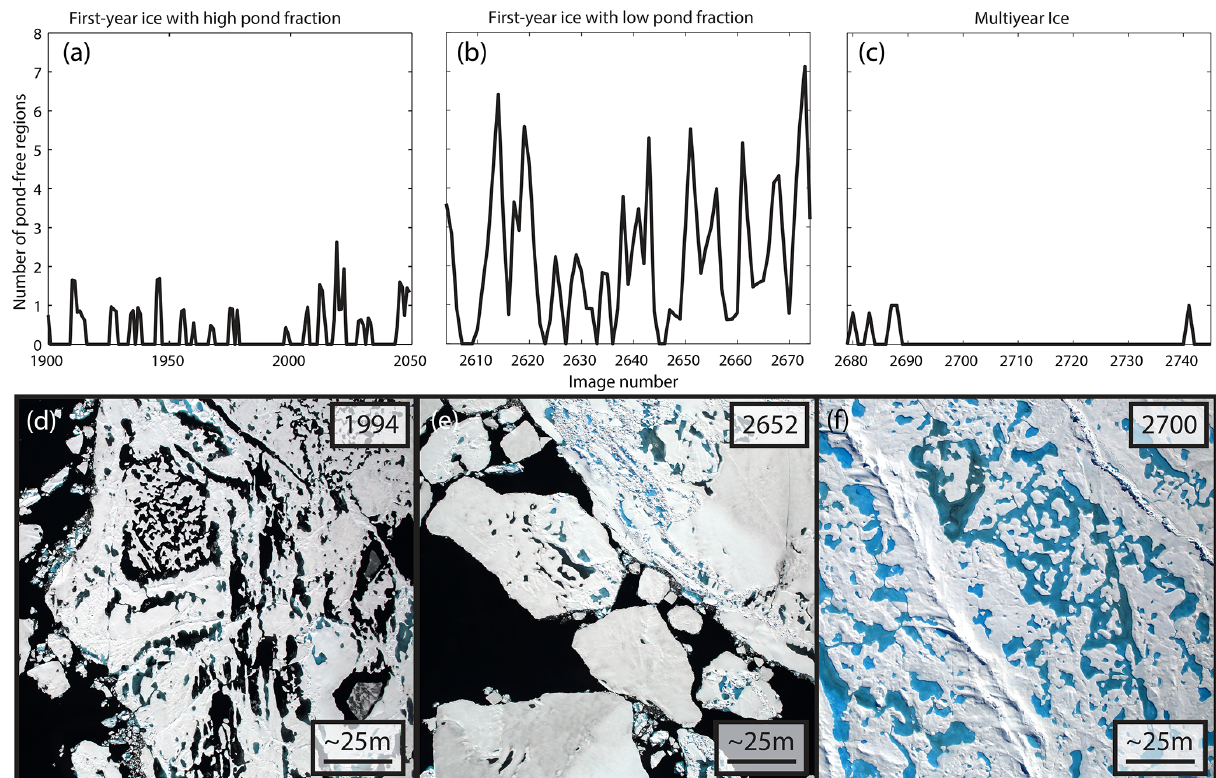
Figure 9. Number of pond-free areas detected over several regions of sea ice observed during the 19 July 2016 flight. Panels (d) , (e) , and (f) show an example image from the regions plotted in panels (a) , (b) , and (c) ,